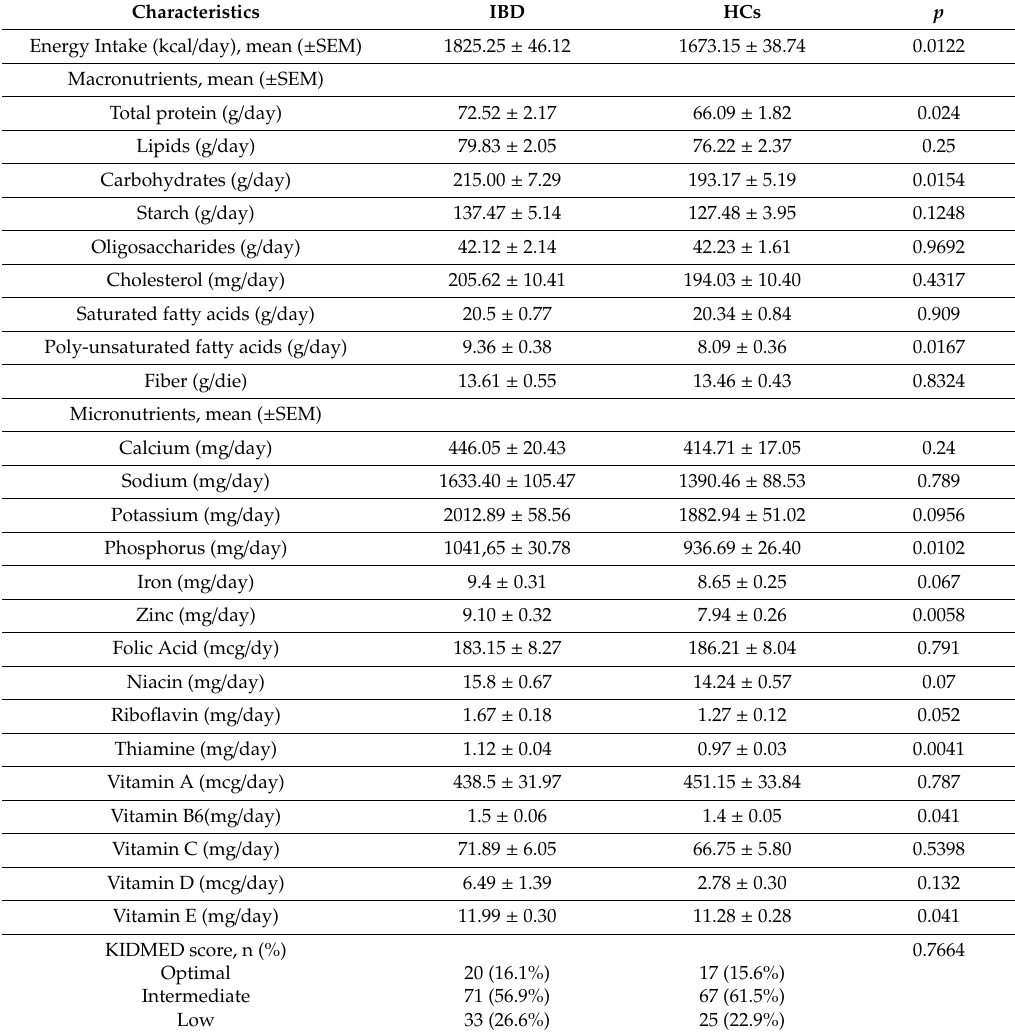
Figure 1. ( a ) Difference in energy intake and macronutrients between children with inflammatory bowel disease (IBD) and the Healthy controls (HCs). ( b ) Difference in micronutrients between children with IBD and the Healthy controls (HCs). Table 2. Energy Intake, Macro and micronutrients between children with IBD and Healty Controls (HCs).